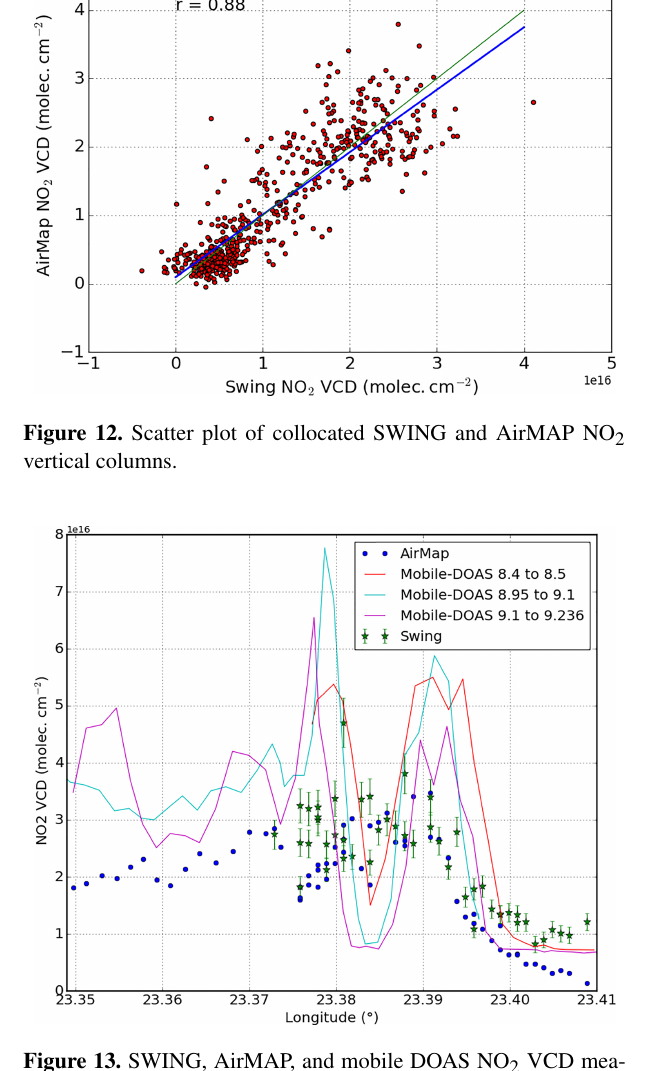
Figure 13. SWING, AirMAP, and mobile DOAS NO 2 VCD mea- surements along the mobile DOAS track on 11 September